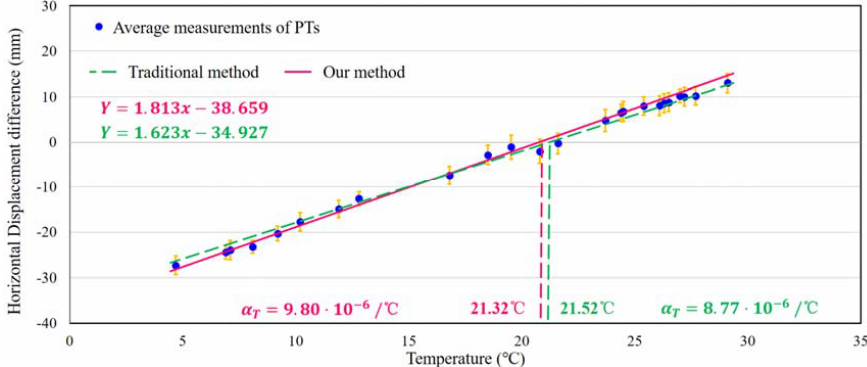
Figure 11. The thermal dilation model of the SNIEC.